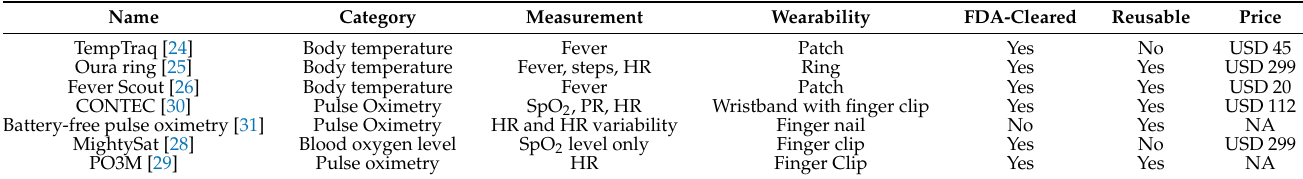
Table 1. Wearables for monitoring body temperature and blood oxygen level.